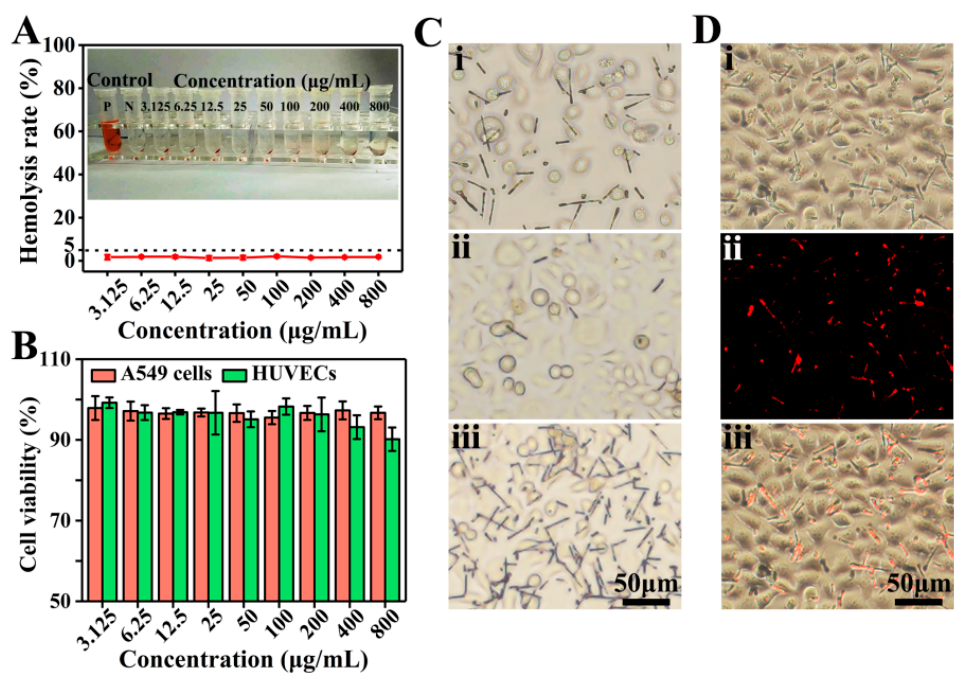
Figure 5. ( A ) Hemolysis rate and photographs of D2 DDCs at concentrations ranging from 3.125 to 800 μ g/mL. ( B ) In vitro cell viabilities of A549 cells and HUVECs normalized to the untreated control after incubation with D2 DDCs for 24 h at concentrations of 3.125–800 μ g/mL. ( C ) Optical microscope images of A549 cells incubated with the D2 DDCs under the effect of a magnet: ( i ) without magnet; ( ii ) far from the magnet; ( iii ) near the magnet. ( D ) Fluorescent microscope images of A549 cells incubated with D2 DDCs: ( i ) bright-field image; ( ii ) fluorescent image; ( iii ) overlay of the bright-field and fluorescent images.